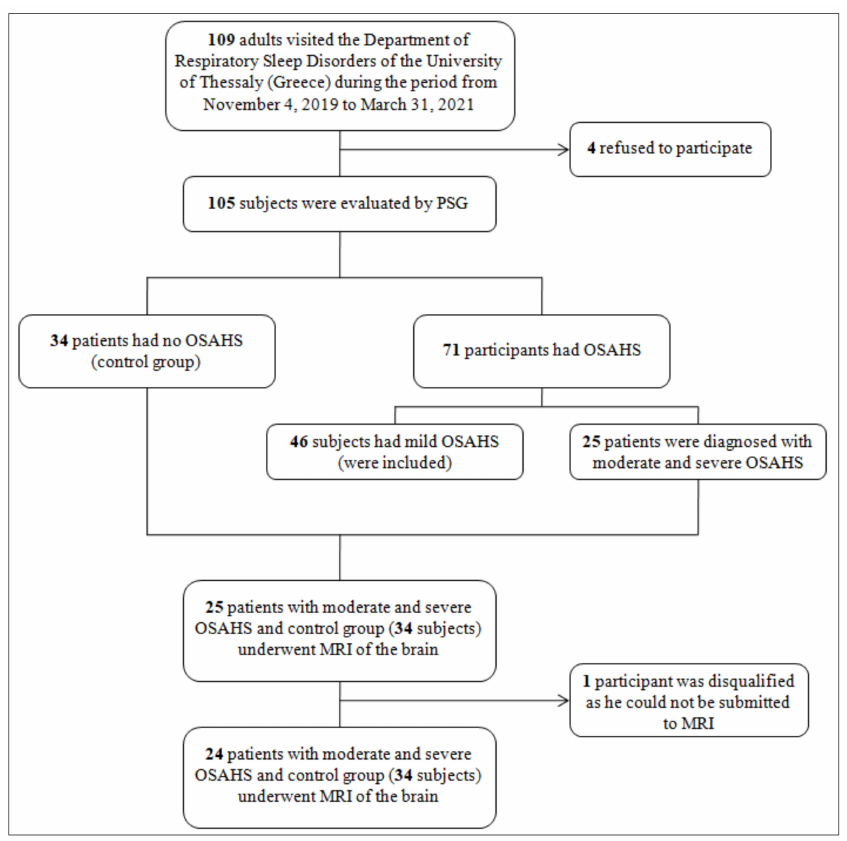
Figure 1. Flowchart of the study selection process and research workflow. List of Abbreviations: OSAHS: Obstructive sleep apnea hypopnea syndrome, PSG: Polysomnography, MRI: Magnetic resonance